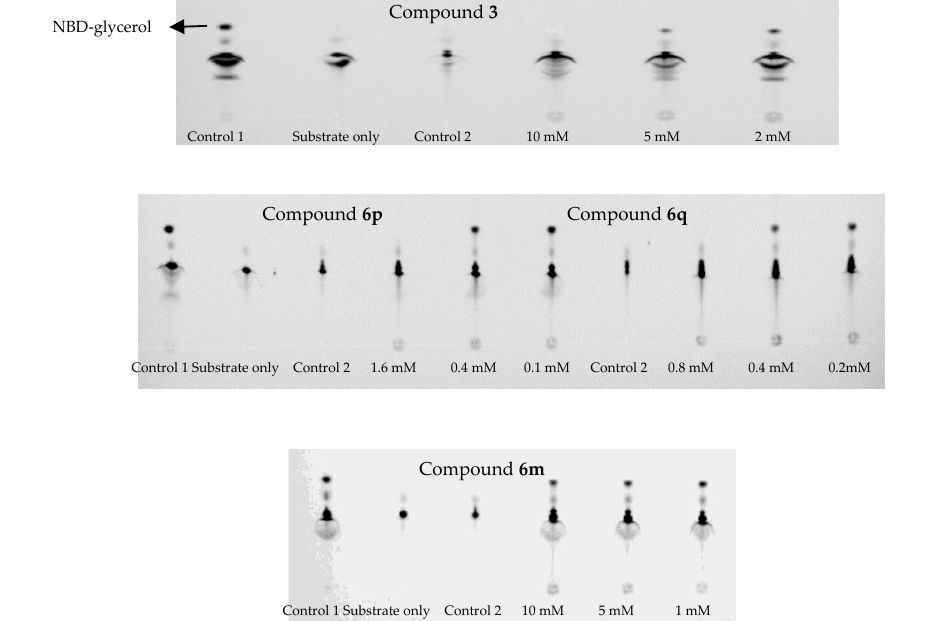
Figure 3. The scheme for the enzymatic reaction catalyzed by the MCR-1 protein.